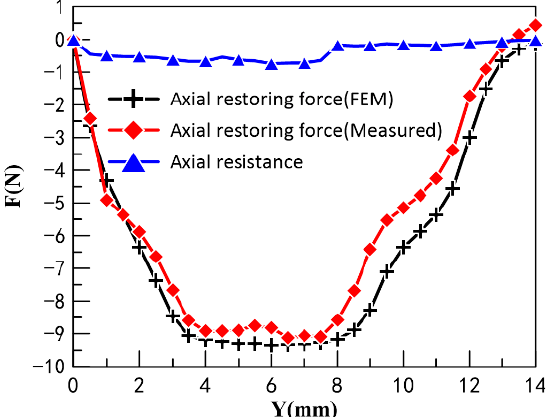
Figure 22. Axial displacement_axial restoring force, Axial displacement_axial resistances. The CPMLTM is not only capable of automatic neutral adjustment, but also has a higher accuracy of neutral adjustment than conventional torque motors. In this study, we measured and plotted the no-load angular displacement curves of two torque motors to compare the accuracy of their neutral adjustment. The zeroing screw and zeroing spring were adjusted to ensure that the four working air gaps between the armature and the pole shoe were equal in thickness before the experiments were conducted on the conventional torque motor to achieve manual neutral adjustment. The no-load angular displacement curve is based on the input current for the horizontal coordinate and the output angular displacement for the vertical coordinate. The experimental data are dimensionless, and the angular displacement curves of CPMLTM and the conventional torque motor are shown in Figure 23. The trajectory of the midpoint of the angular displacement curve is called the nominal angular displacement curve, and the ratio between the input current value and the rated current required to keep the torque motor in the neutral position is called its zero bias. The zero bias of the torque motor reflects the accuracy of its neutral adjustment, and the zero bias of the CPMLTM is 0.9%, compared to 32.5% for the conventional torque motor. The zero bias of CPMLTM is smaller than that of conventional torque motors, which